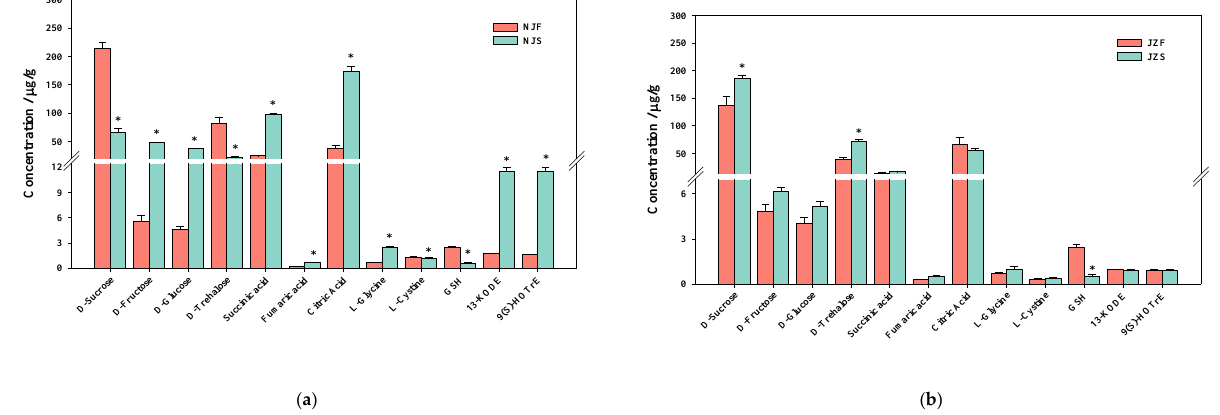
Figure 6. ( a ) Relative quantification of metabolites in NJF vs. NJS group. ( b ) Relative quantification of metabolites in JZF vs. JZS. *: means the stored group is significantly different compared with the fresh group in the same variety when α =